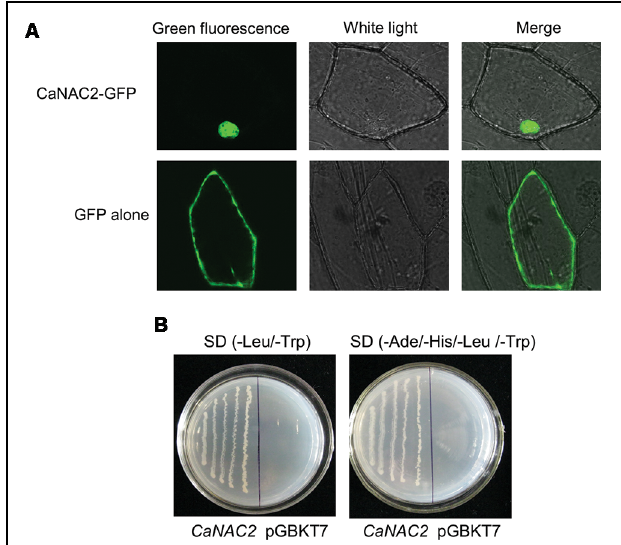
FIGURE 2 | The subcellular localization and transcriptional activation analysis of pepper CaNAC2 . (A) The subcellular localization of pepper CaNAC2 in onion epidermal cells. The fused pBI221-GFP- CaNAC2 and pBI221-GFP constructs were introduced into onion epidermal cells by biolistic bombardment. The GFP signals were observed under confocal microscope; (B) Transcriptional activation analysis of CaNAC2 in yeast strain AH109. CaNAC2 represents the fusion protein of the GAL4 DNA-binding domain and CaNAC2; pGBKT7 was used as control. The culture solution of the transformed yeast was streaked on SD/-Leu/-Trp medium and SD/-Ade/-His/-Leu/-Trp medium. The plates were incubated for 3